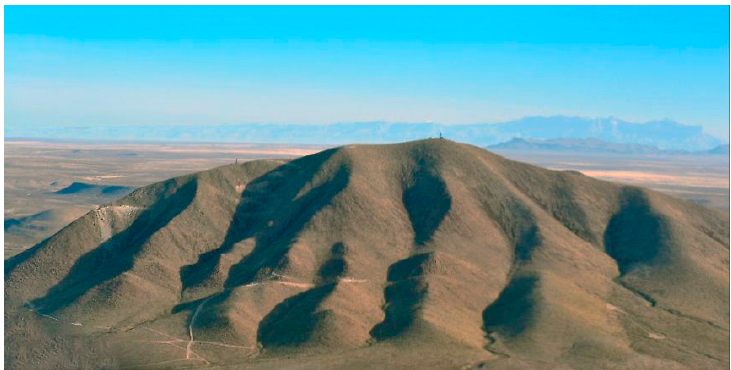
Figure 1. Round Top Mountain yttrium and the heavy rare earth elements (YHREE) deposit, Hudspeth County, west Texas, USA. Virtually the entire mountain, extending a short distance into the subsurface, is mineralized. Note drill rig on peak for scale.